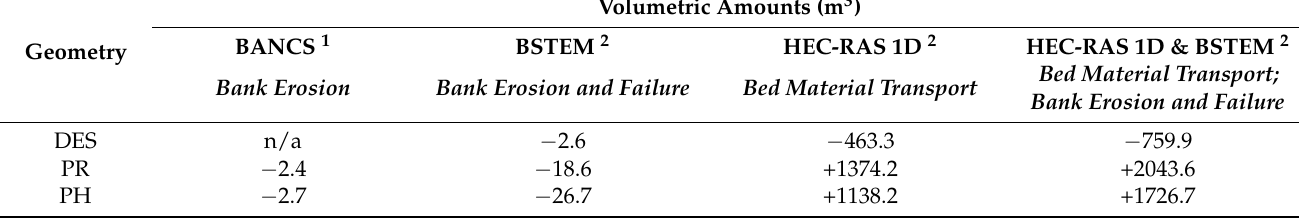
Table 7. Volumetric amounts of geomorphic change for the Design (DES), Post-Restoration (PR), and Post-Hurricane (PH) geometries based on predictions from BANCS, BSTEM, HEC-RAS 1D, and HEC-RAS 1D &